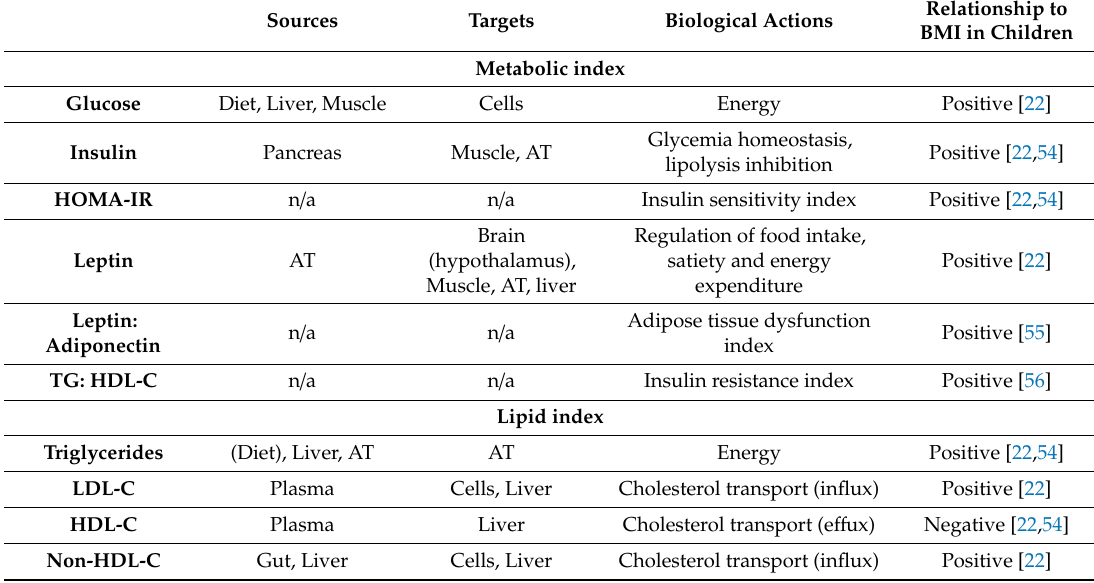
Table 1. Characteristics and evidence for the selection of the biomarkers included in the metabolic, lipid and anti-inflammation